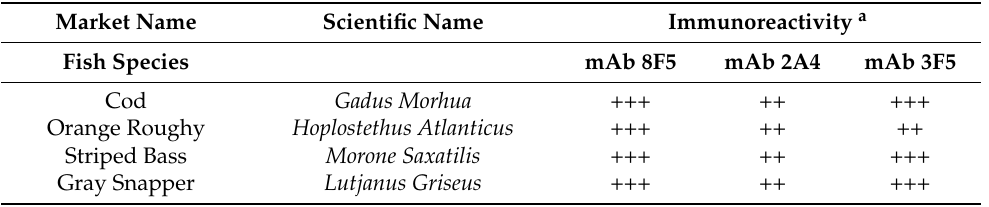
Table 1. Immunoreactivity of 3 anti-fish mAbs (8F5, 2A4, 3F5) against 50 species of fish, three shellfish, 11 land animals, and four food additives by indirect